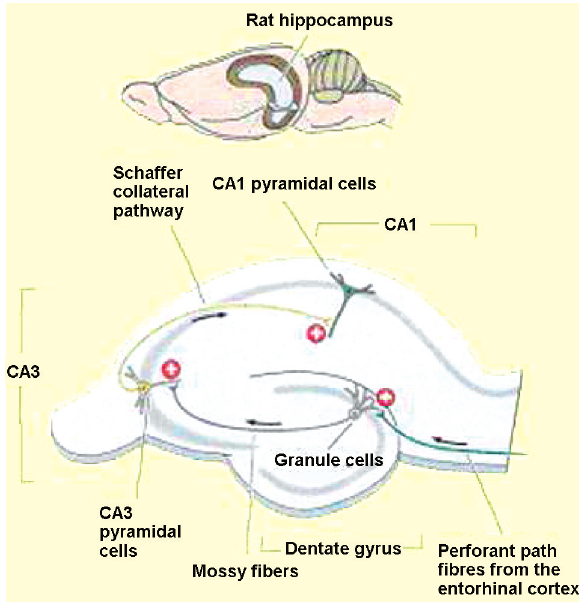
Figure 2. The trisynaptic loop. Figure from http://lecerveau.mcgill.ca/flash/ a/a 07/a 07 cl/a 07 cl tra/a 07 cl tra.htm.